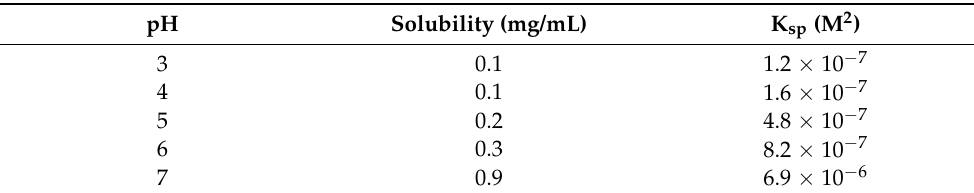
Table 1. Effect of pH on the solubility of warfarin sodium and its K sp values.